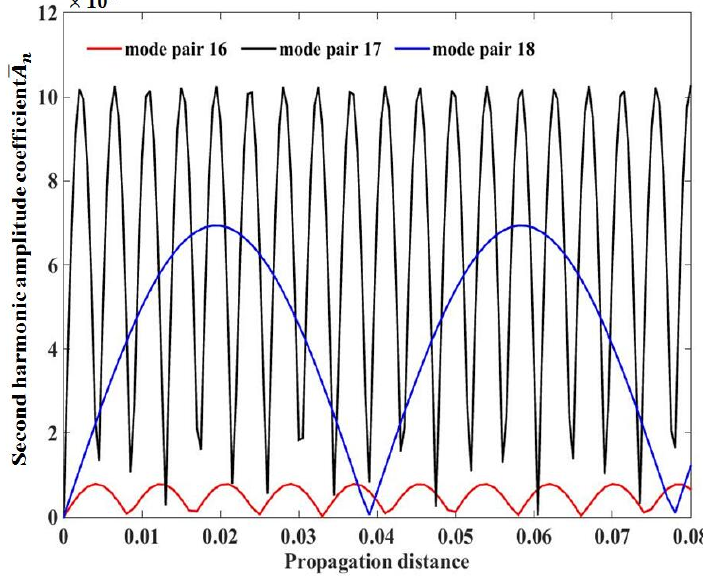
Figure 5. Amplitude coefficients of cumulative second harmonic modes vary according to propagation distance.